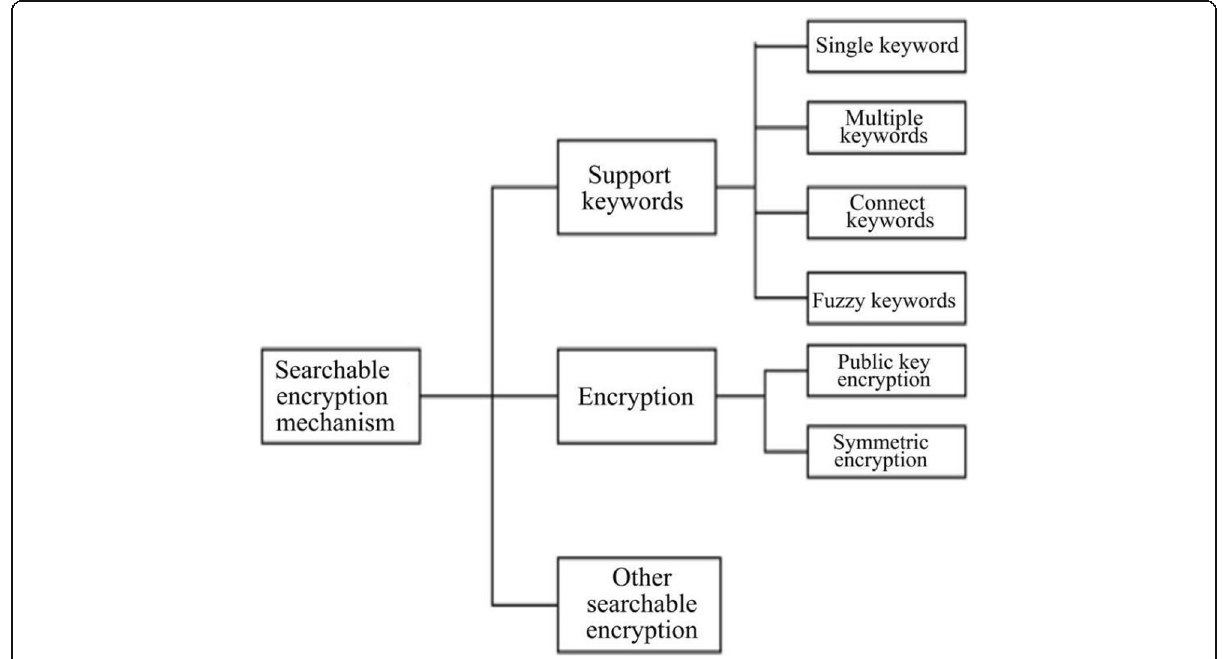
Fig. 3 Searchable encryption mechanism research